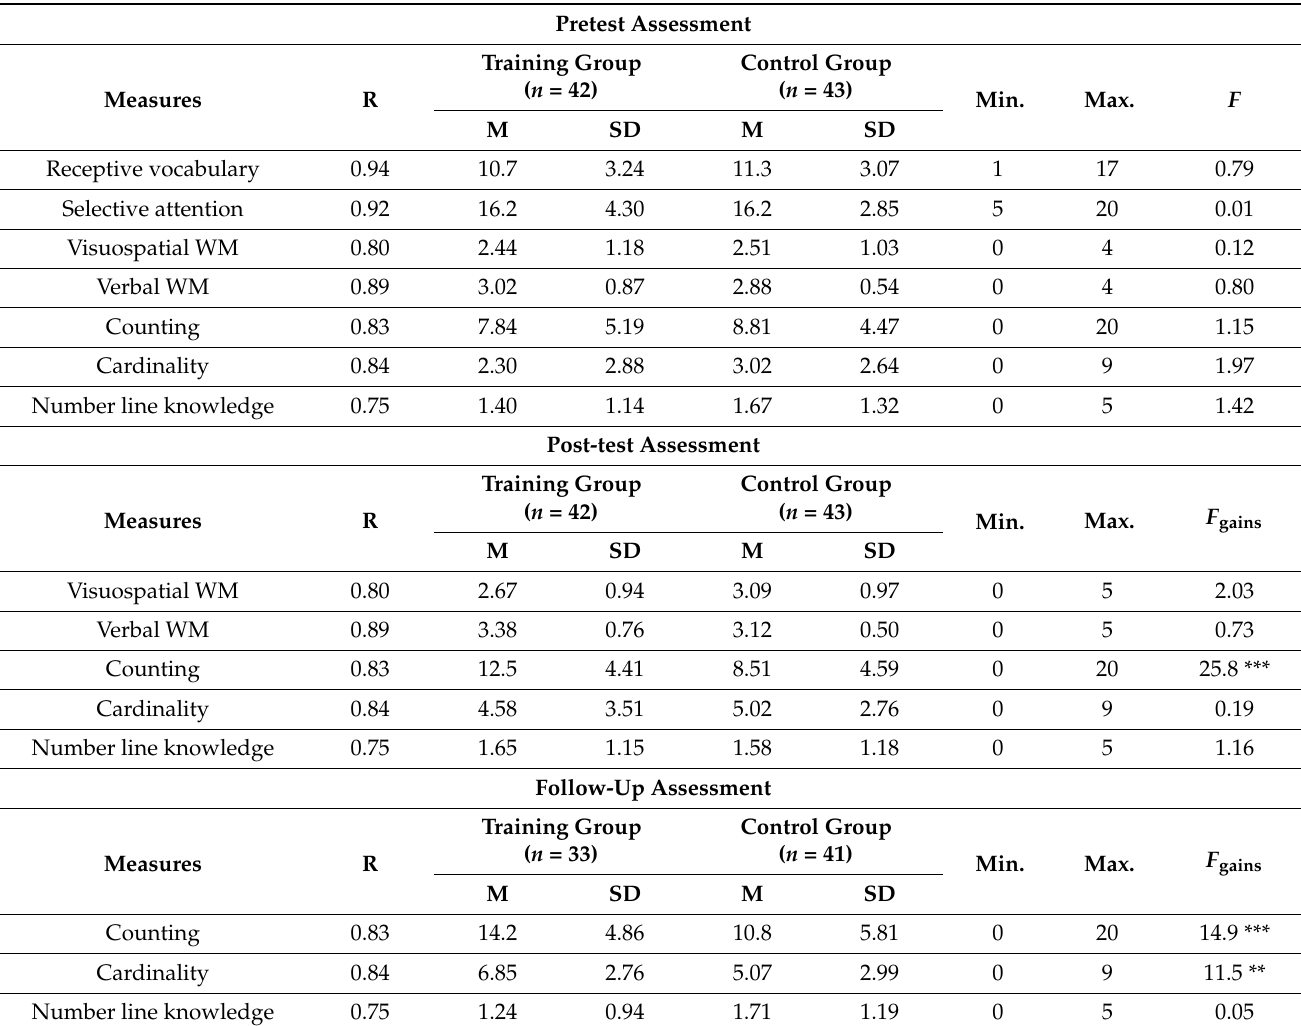
Table 2. Reliabilities (R), mean scores (M), standard deviations (SD), minimum (Min.) and maximum (Max.) scores, and univariate test results ( F and F gains from MANOVA) in the different measures for the two groups at the three time points (pretest, posttest, follow-up). ** p < 0.01, *** p <